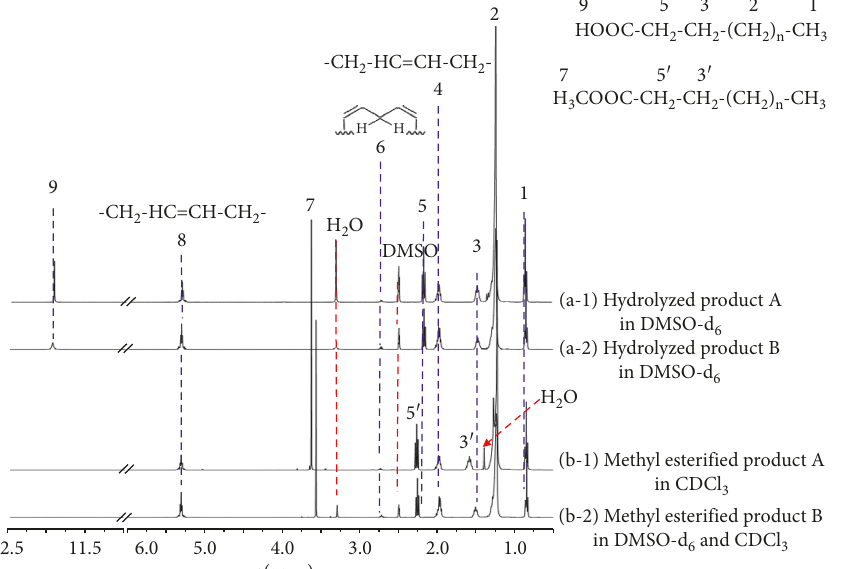
Figure 5: Stacked 1 H NMR spectra of the hydrolysed products and the methyl-esterified products from two kinds of fatty acid zinc salts A and B.